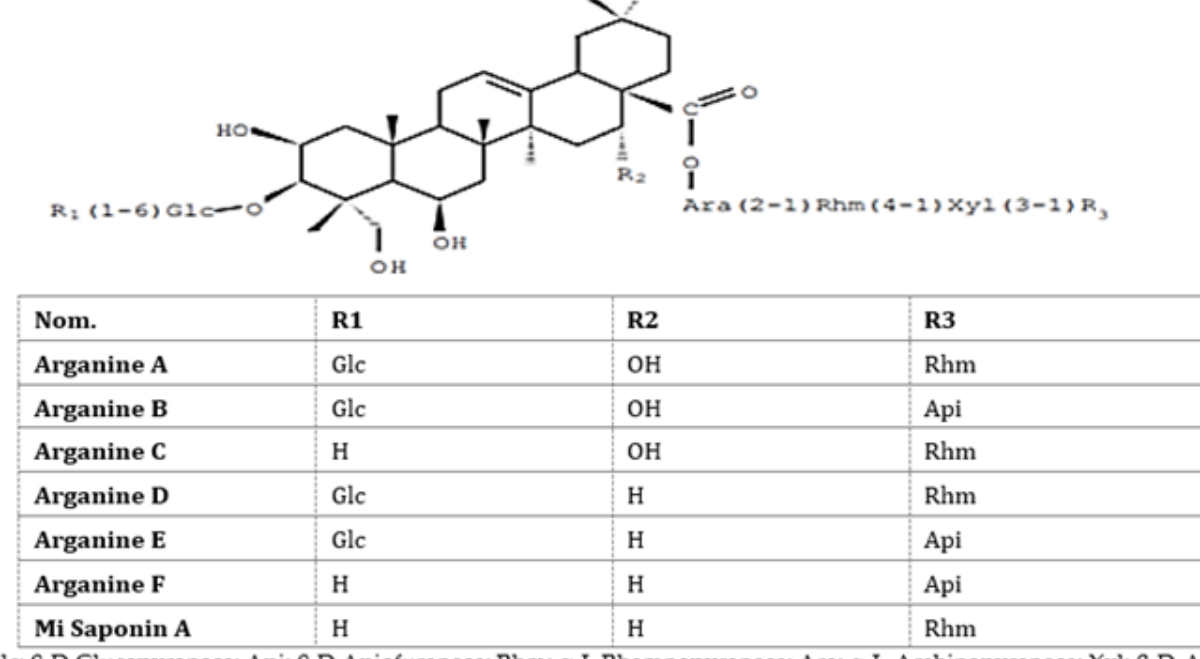
Figure 1. Chemical structure of Argania spinosa saponins [21]. Copyright © 1992 Published by Elsevier